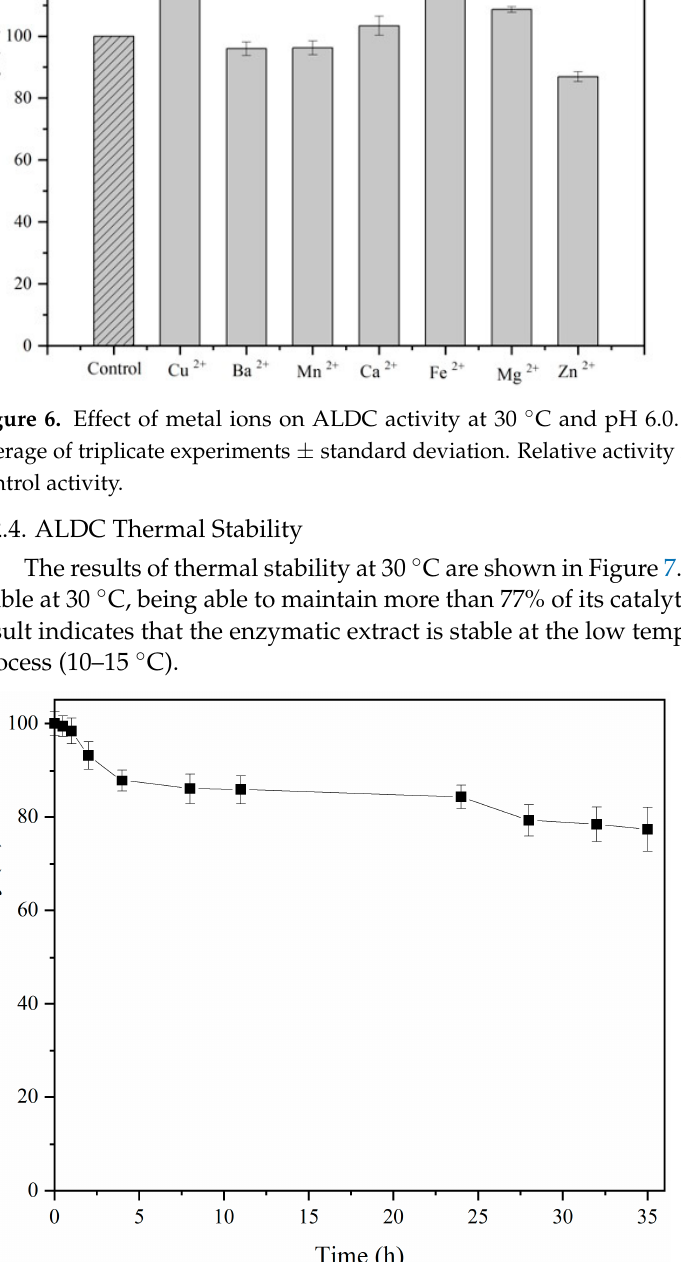
Figure 7. Thermal deactivation profile for ALDC at 30 °C in 50 mM MES buffer at pH 6.0.